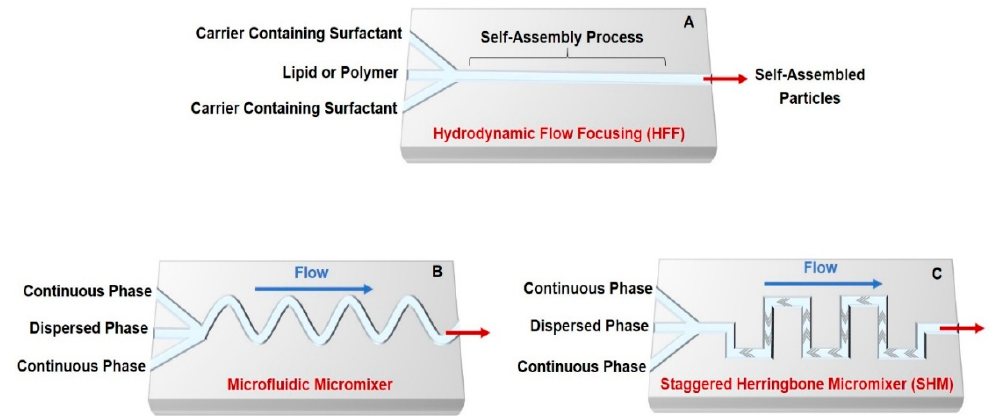
Figure 1. Microfluidic platforms for generation of self ‐ assembled drug and gene carriers: ( A ) schematic of a simple hydrodynamic device with HFF; ( B ) schematic of a simple microfluidic mixing chamber; and ( C ) schematic of SHM for chaotic mixing Figure modified from References [19,28,29].